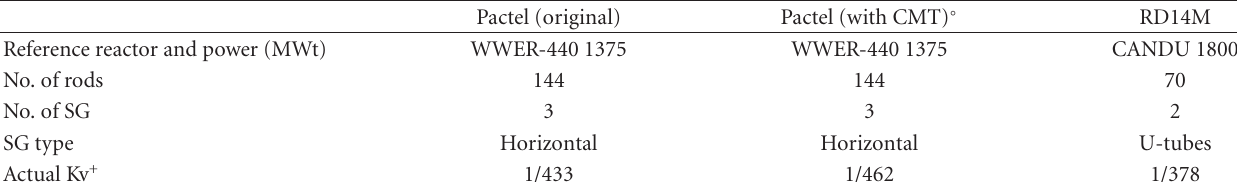
Table 3: PACTEL and RD14M.